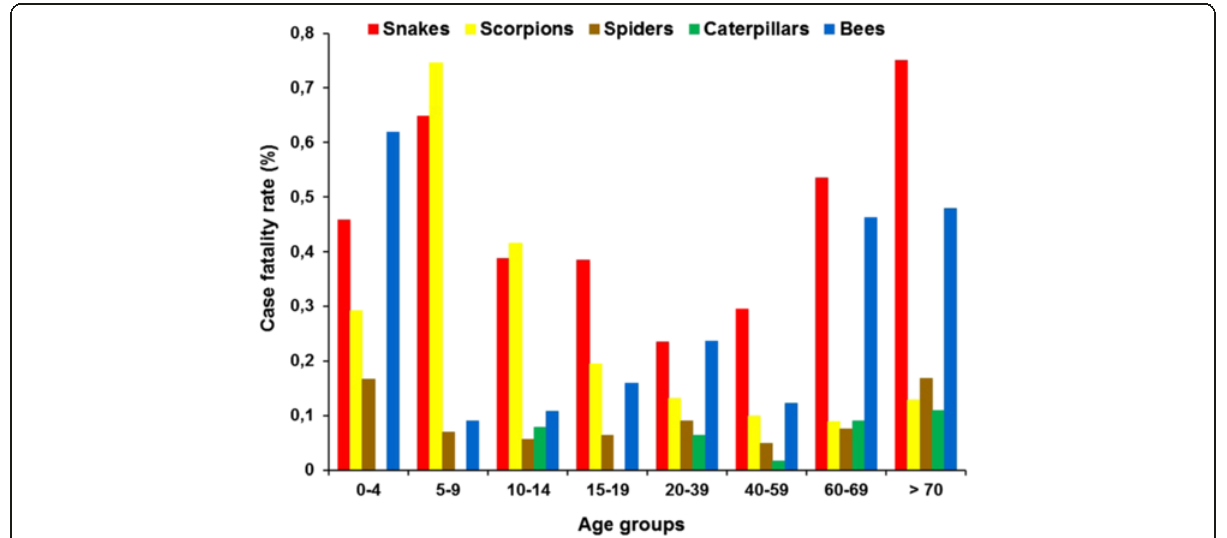
Fig. 15 Case fatality rate according to venomous animals and age